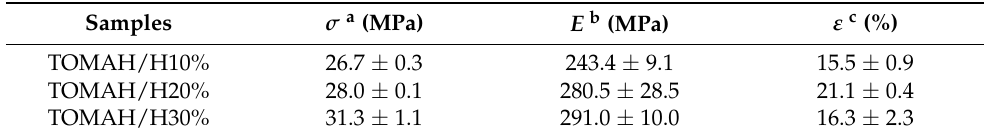
Table 4. Tensile properties of the UV-cured TOMAH/H